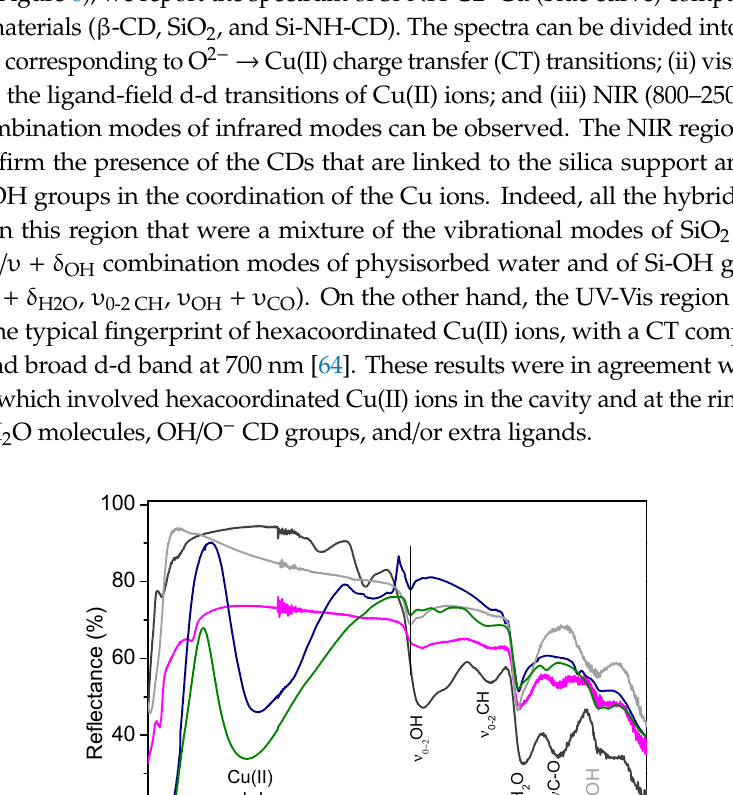
Table 2. Panel test of the CuAAC reaction. Entry